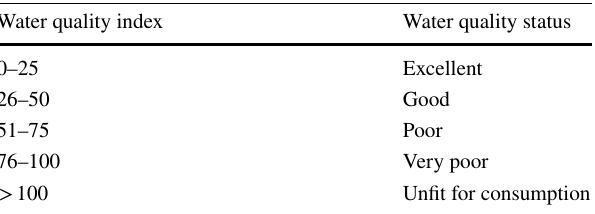
Table 3 Water quality index ranges and their designations developed by Brown et al